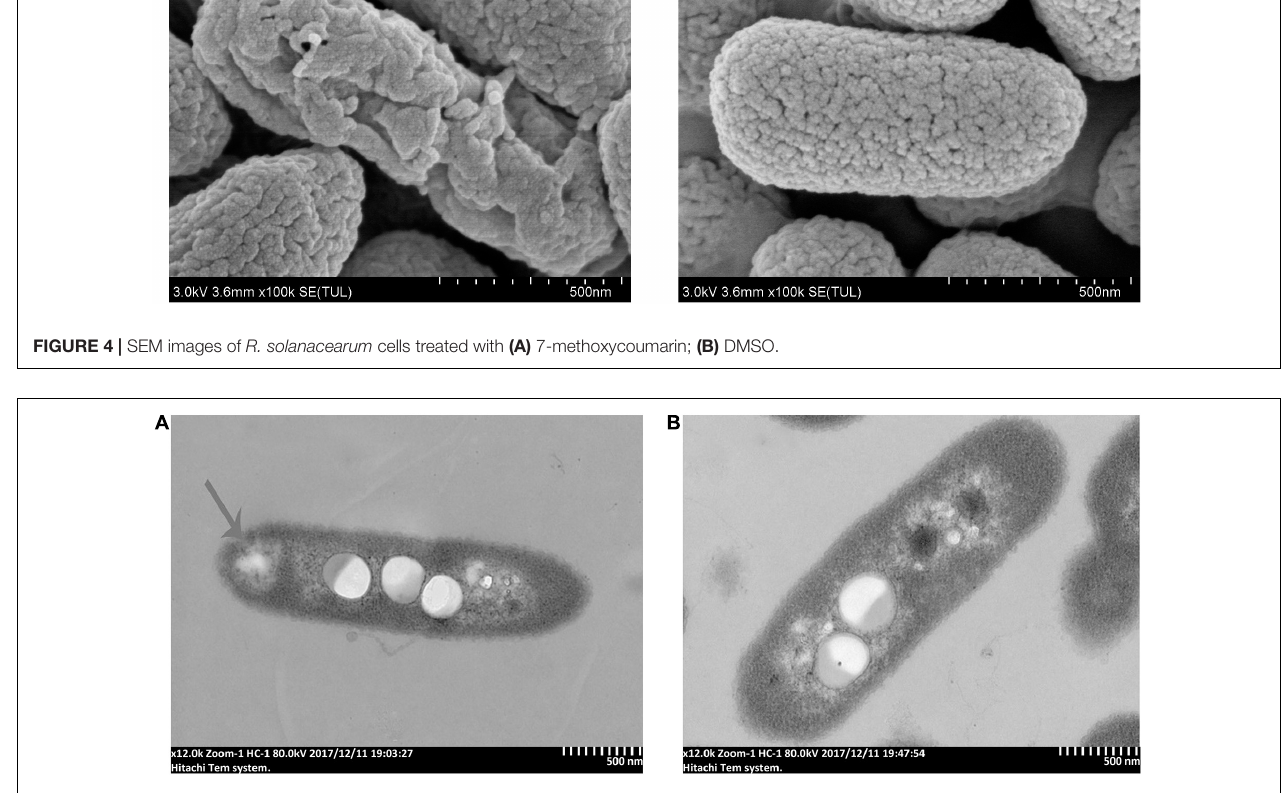
FIGURE 5 | TEM images of R. solanacearum cells treated with (A) 7-methoxycoumarin; (B) DMSO.